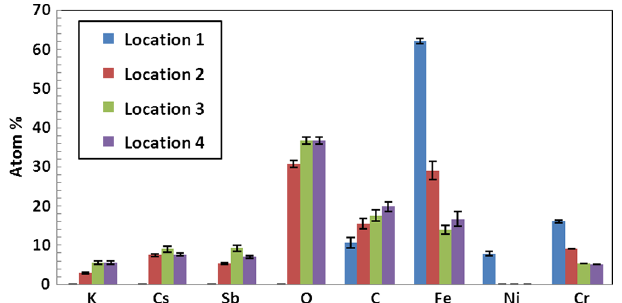
FIG. 18. EDS spectra taken from 400 x images of locations 1–4 from photocathode #1. Notice location 1 has a purely stainless steel composition.